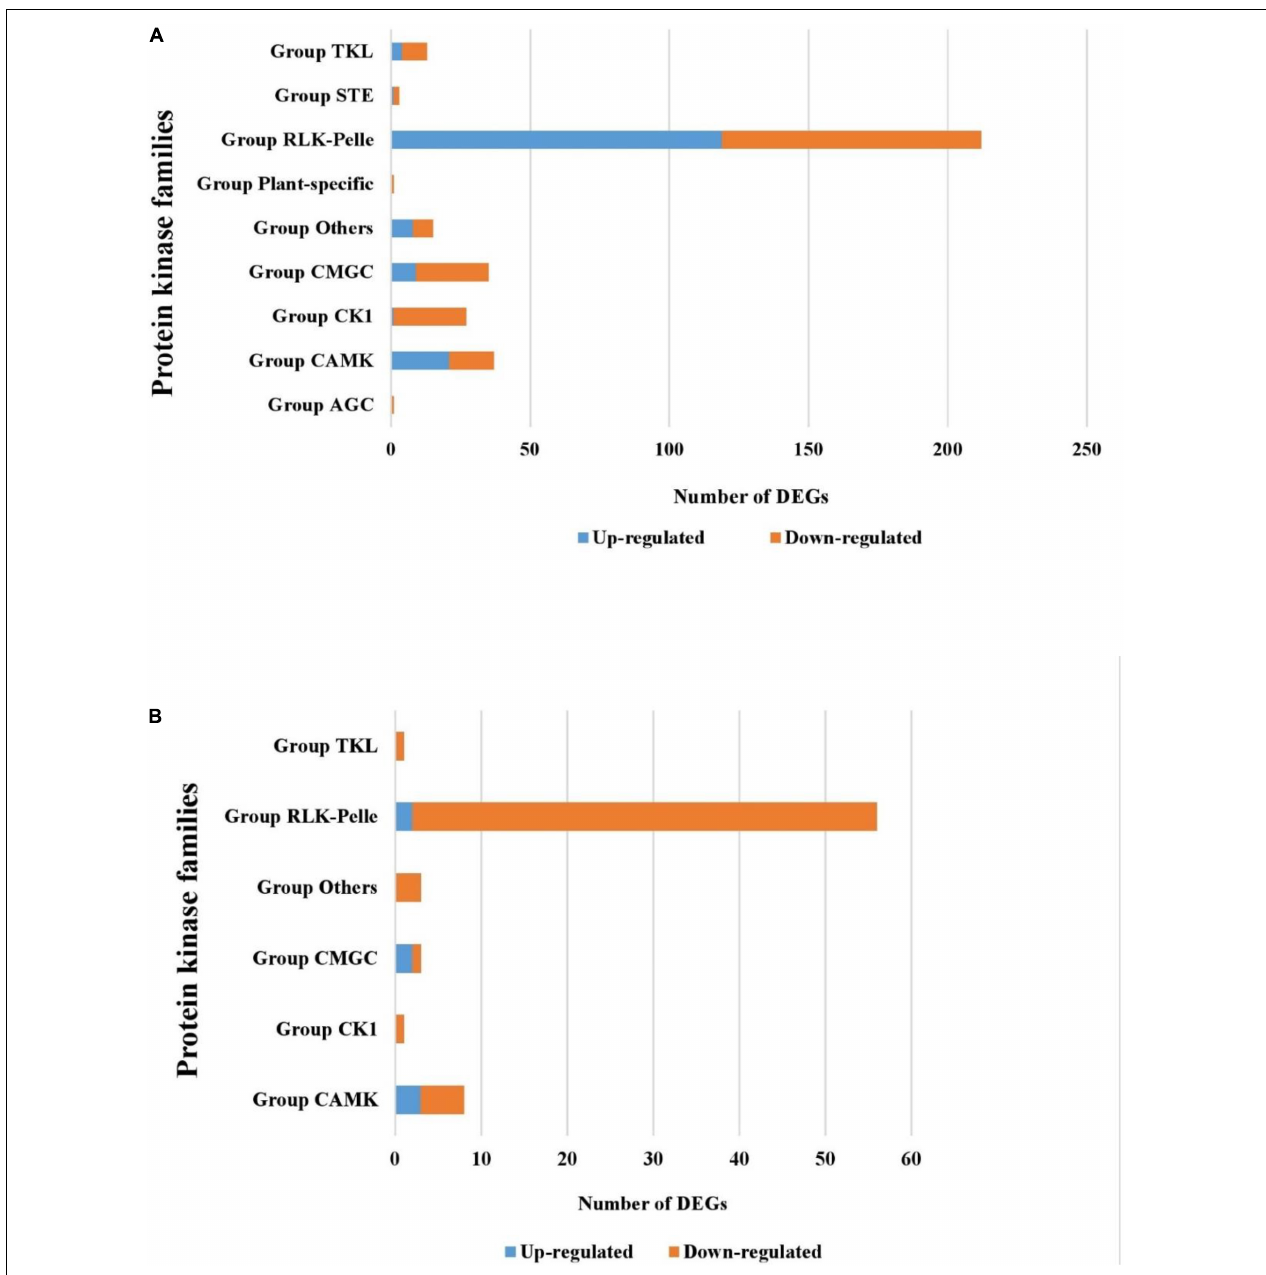
FIGURE 5 | Differentially expressed kinase genes [protein kinases (PKs)] detected in the tolerant wild genotype (A) and the sensitive cultivar ‘Mona’ (B)